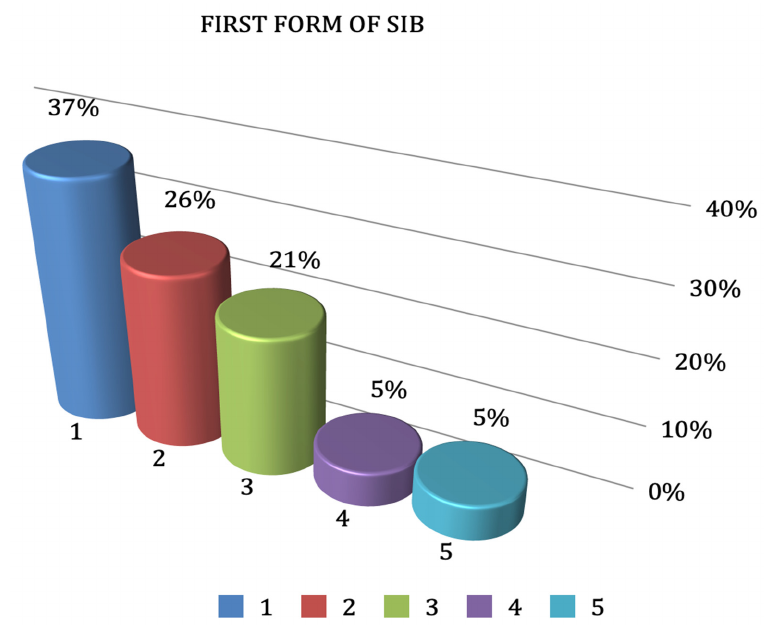
Figure 1. Incidence of the first forms of self ‐ mutilation. 1: finger biting; 2: lip biting; 3: tongue biting; 4: throwing oneself backwards; 5: head banging. Among patients displaying oral self ‐ mutilation, the most frequent was lip biting 17/19 (89%), followed by tongue biting 11/19 (58%) and cheek biting 10/19 (53%). Less frequent manifestations were vestibular and gum lesions, each seen with a frequency of